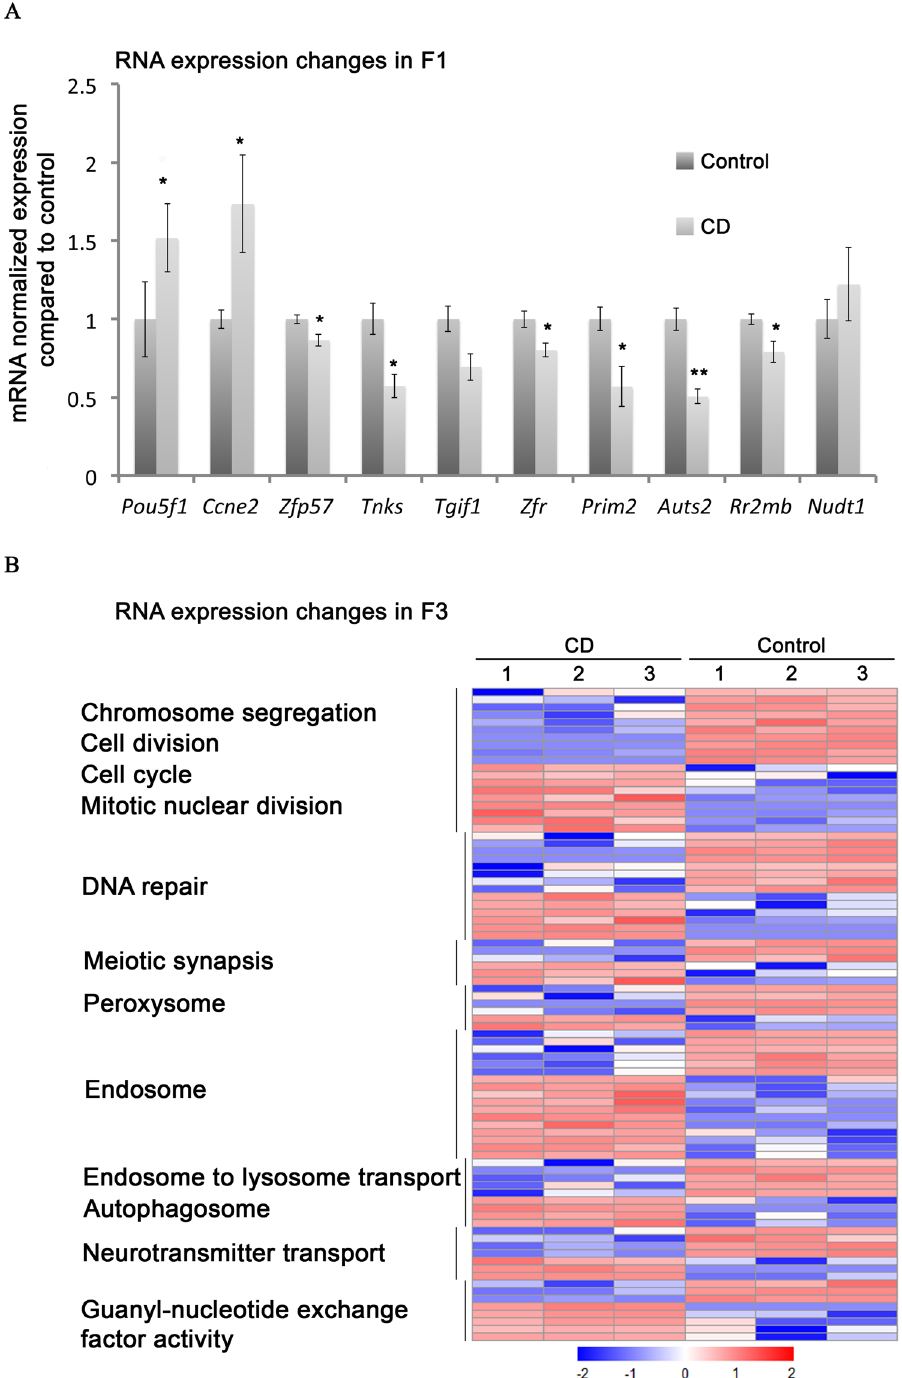
Figure 4. RNA expression changes in F1 and F3 CD-derived adult males. ( A ) The RT-QPCR data of RNA expression in F1. The RNA from 5 animals for each condition was extracted, reverse transcribed and analysed by qPCR for each target gene. The copy numbers of each target gene were normalised to Actb copy numbers, and data were presented as normalised values compared to control + / − SEM, ( * p < 0.05, ** p < 0.001, t-test). ( B ) A heatmap of the differentially expressed genes in the testes. The hierarchical cluster analysis identified 8 gene groups that could be segregated according to their expression levels in testis fractions. Red indicates high and blue indicates low